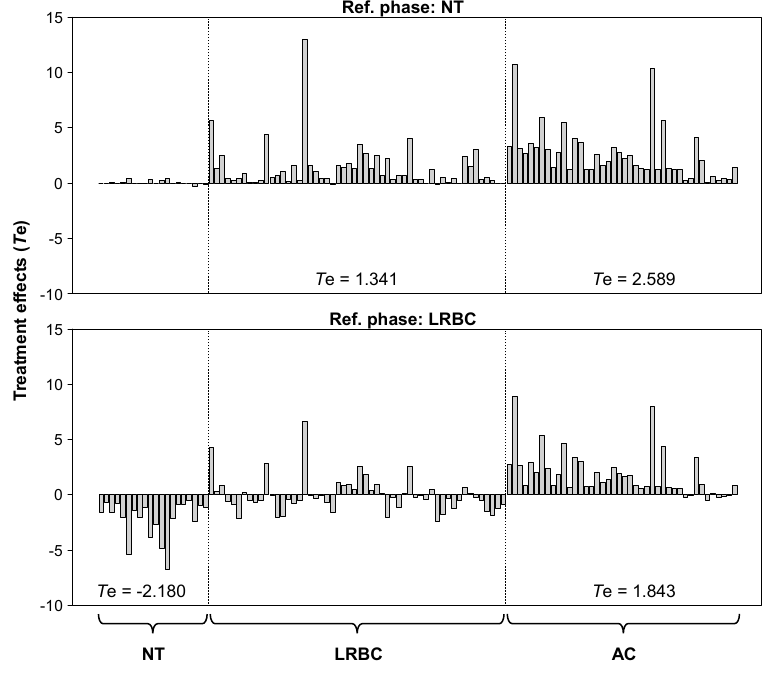
Figure 10. Treatment